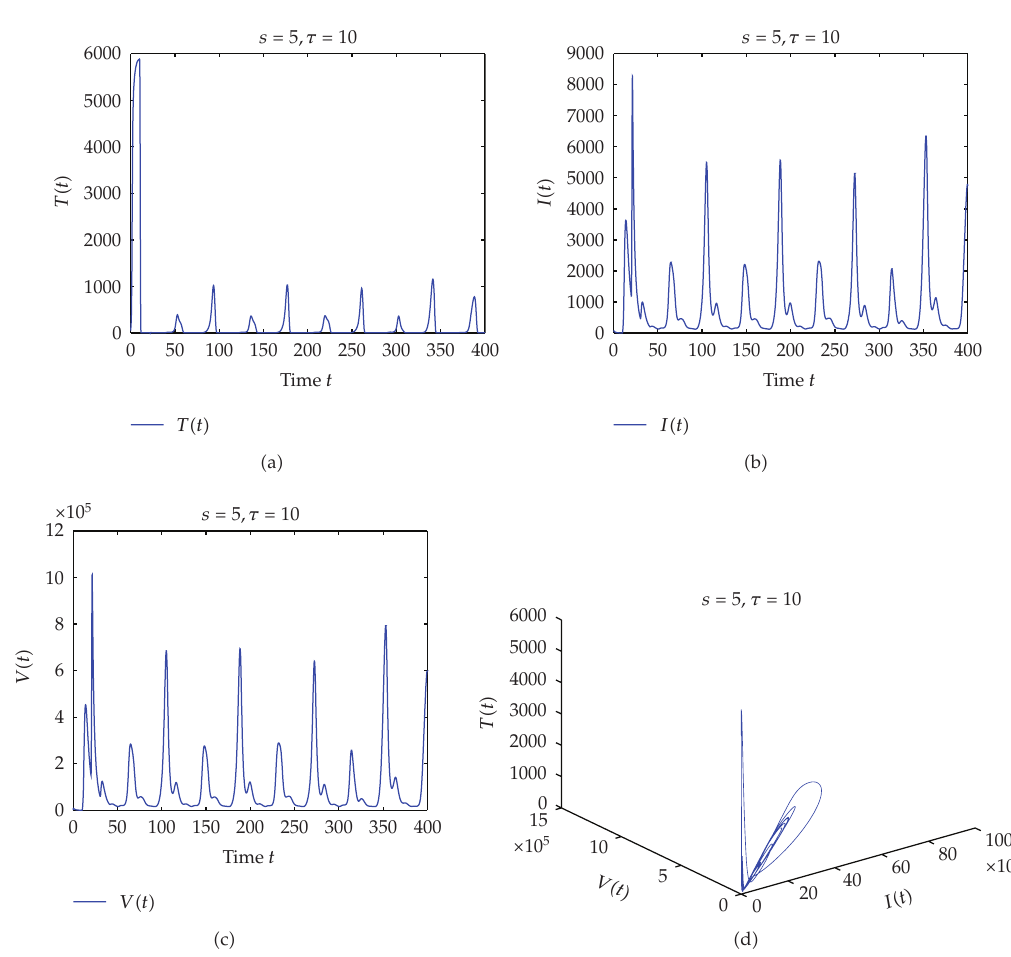
Figure 2: (cid:4) a (cid:5) – (cid:4) c (cid:5) are the oscillations of uninfected cells, infected cells, and virus, (cid:4) d (cid:5) shows that there is